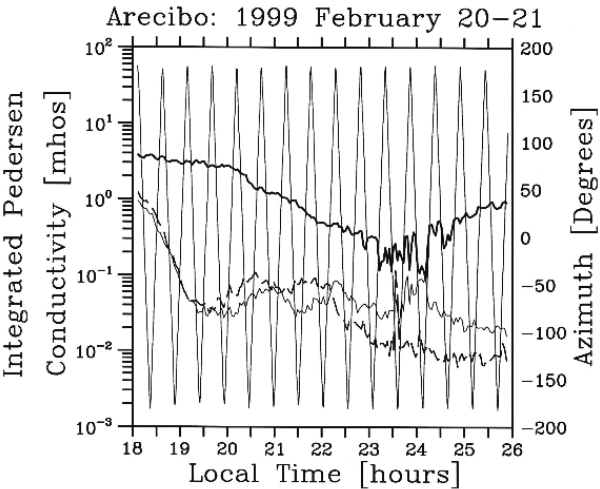
Fig. 5. E-region (light solid line), F-region (heavy solid line), and valley-region (dashed line) Pedersen